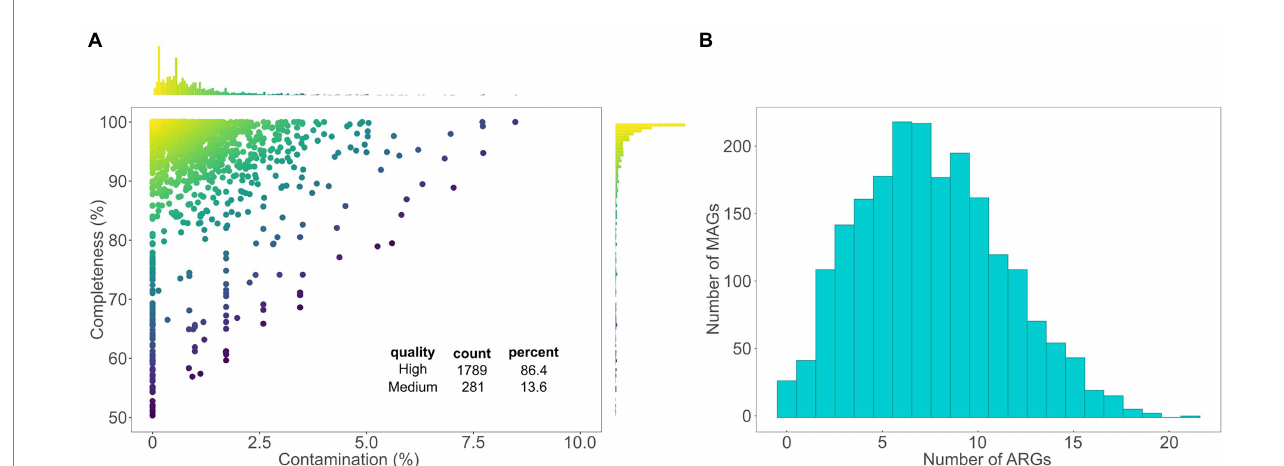
FIGURE 1 MAG quality and number of ARGs. (A) A scatter plot showing the contamination and completeness levels of the 2,073 MAGs that clustered in the gOTU picking. The two histograms show the distribution of contamination and completeness among the MAGs. Each point is colored according to its quality score (Methods). Medium quality MAGs have completeness higher than 50% and contamination lower than 10%. High-quality MAGs have completeness higher than 90% and contamination lower than 5%. All MAGs have a quality score higher than or equal to 50. (B) A histogram showing the number of ARGs found in each of the 2,073 MAGs that clustered in the gOTU